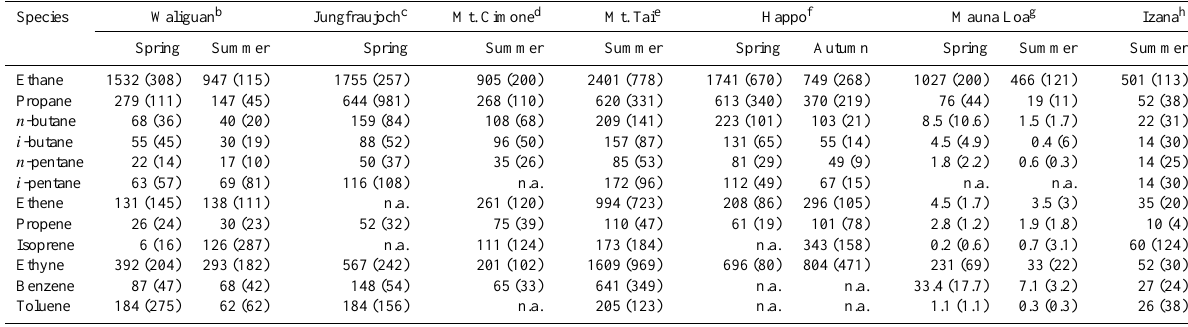
Table 2. Comparison of major hydrocarbon levels at WLG with observations at other mountain sites a . Species Waliguan b Jungfraujoch c Mt. Cimone d Mt. Tai e Happo f Mauna Loa g Izana h Spring Summer Spring Summer Summer Spring Autumn Spring Summer Summer Ethane 1532 (308) 947 (115) 1755 (257)